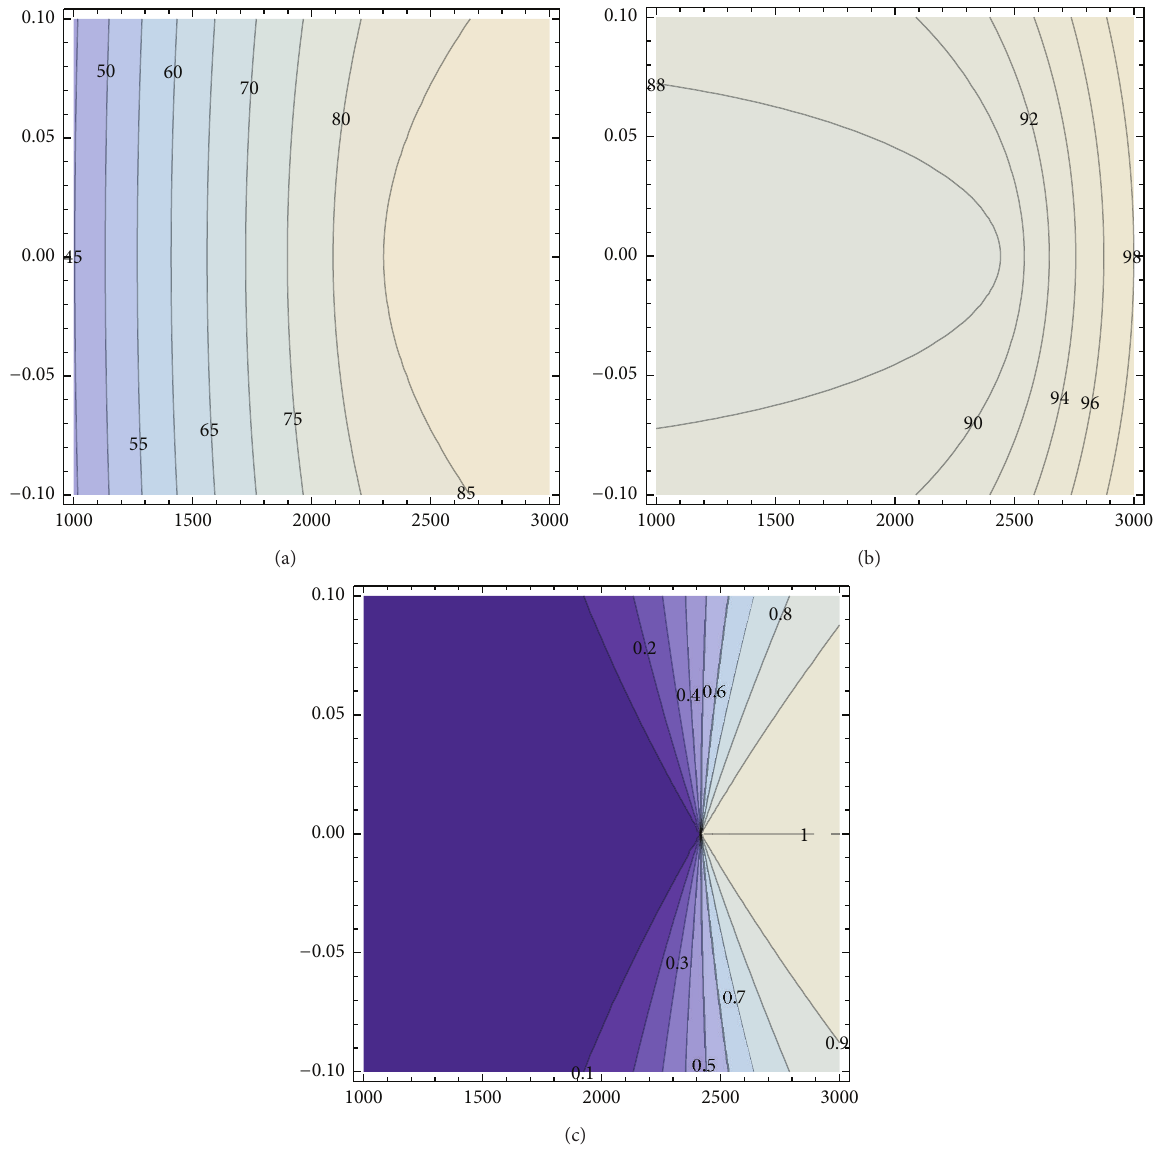
Figure 7: The two lightest eigenvalues of the scalar mass matrix at tree-level ((a) and (b)) and the bilepton fraction of the lightest eigenstates (c) in the ( 𝑥;𝑔 𝑌𝐵 )